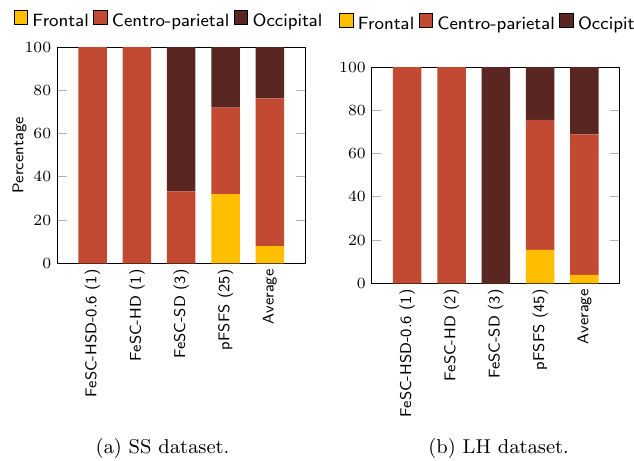
Fig. 3 Percentage of iterations in which each EEG feature was selected as stable by the different algorithms (threshold was set to 70%). To note, algorithms were sorted by the increasing number of stable features